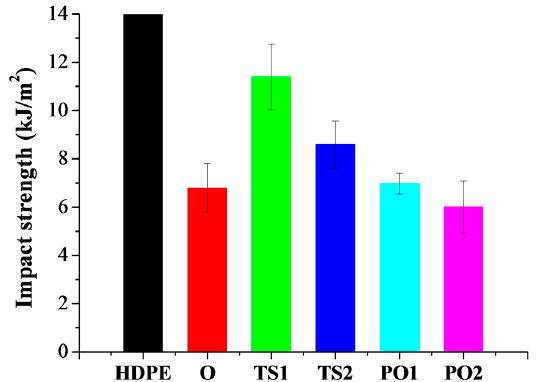
Figure 6. Impact strength of pulp fiber/HDPE composites. The neat HDPE was unbroken. Composite O: wet pulp fiber/HDPE mixture was dried by oven. Composite TS1: wet pulp fiber/HDPE mixture was dried by twin-screw extruder. Composite TS2: mixture TS1 was melt-extruded again. Composite PO1: wet pulp fiber/HDPE mixture was dried by prepressing and oven. Composite PO2: mixture PO1 was melt-extruded